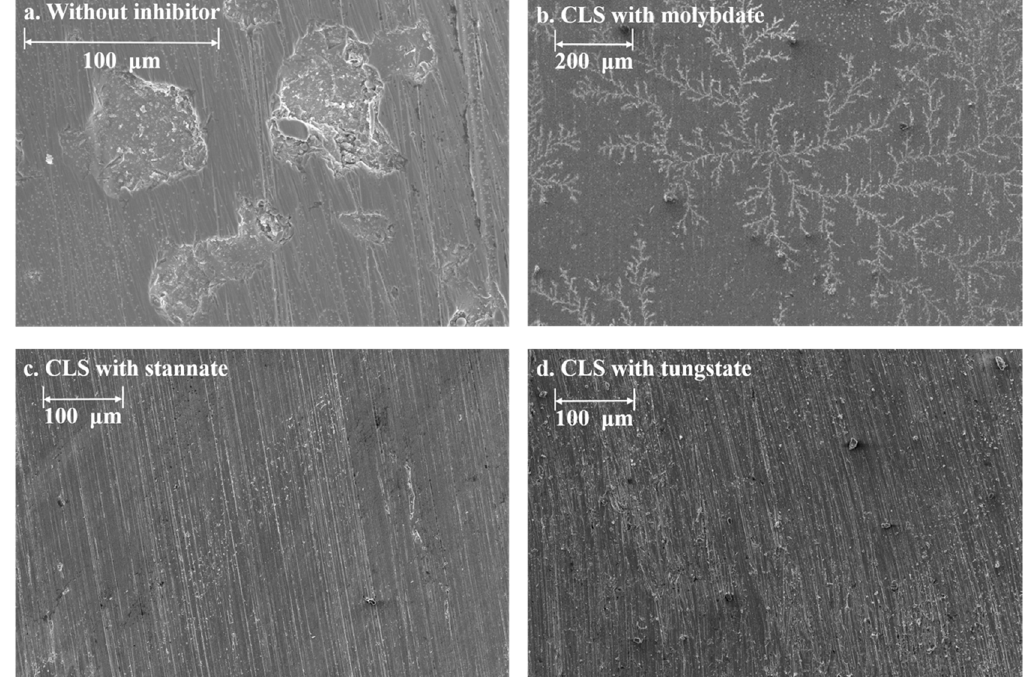
Figure 9. The surface morphology of Q235 carbon steel immersed in test solution without or with 500 ppm hybrid inhibitors: ( a ) without inhibitor; ( b ) CLS with molybdate; ( c ) CLS with stannate; ( d ) CLS with tungstate.